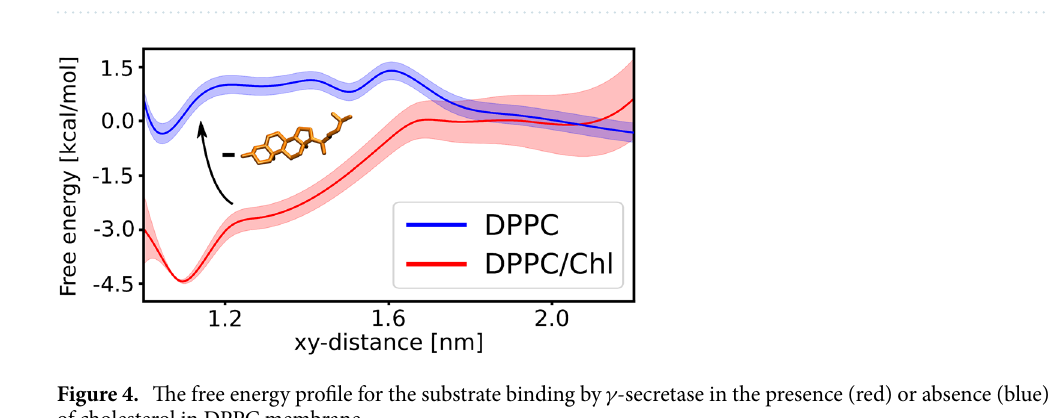
Figure 3. Spatial variations in the average membrane thickness in proximity of the γ -secretase exosite and β -CTF: isolated (left, xy -distance = inf ), at the slope of the free energy profile for the substrate binding (middle, xy -distance = 1.6 nm) and in complex (right, xy -distance = 1.1 nm). The perimeter (p) of the membrane regions thinned by the proteins is represented with dashed lines.